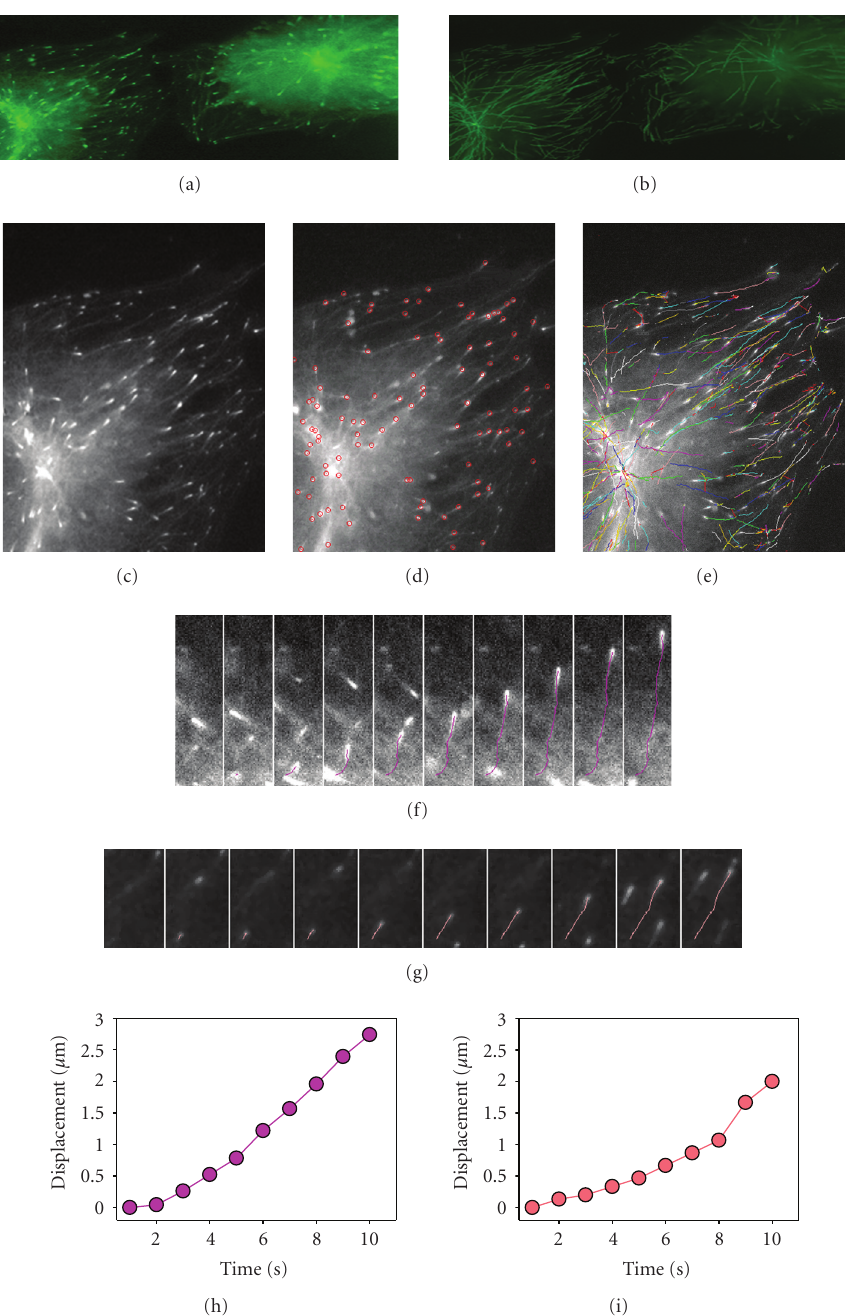
Figure 2: Selective visualization of growing microtubule plus-ends in human EC. EB3-GFP was used as a marker of growing distal tips (plus- ends) of microtubules. HPAEC were transfected with the plasmid expressing EB3-GFP and the cells growing in monolayer were selected for analysis. Not all cells in the monolayer expressed the construct, and, therefore, could be detected in the fluorescence micrographs. Persistent microtubule growth was confirmed by long EB3-GFP tracks. EB3-GFP movement was analyzed by time-lapse microscopy. Images were acquired every 1 second. ((a), (b)) Two neighboring EC expressing EB3-GFP, low magnification. (a) EB3-GFP tracks oriented radially from the centrosome can be seen to elongate persistently. EB3-GFP is presented at microtubule plus-ends during growth phases but disappears after transition from growth to pause or shortening phase. (b) EB3 tracks obtained by EB3-GFP patches displacement on time-lapse series during 60 second. Scale bar, 10 μ m. ((c)–(e)) High magnification of left cell from two EB3-GFP expressing EC shown in ((a), (b)): (c) first frame; (d) the same frame with EB3-GFP patches marked with red circles for analysis; (e) EB3 tracks obtained by EB3-GFP patches displacement on time-lapse series during 60 seconds (are colored individually). Scale bar, 10 μ m. ((f), (g)) High magnification of the frames 1–10. (f) Ten consecutive frames (1–10 sec.) showing the movement of EB3-GFP comet on microtubule tip growing radially from the centrosome region. EB3 tracks (purple) obtained by EB3-GFP patches displacement during 10 seconds. (g) EB3 tracks (pink) obtained by EB3-GFP patches displacement during 10 second near the cell margin. (h) Quantification of plus-ends displacement of microtubules shown in (f). (i) Quantification of plus-ends displacement of microtubules shown in